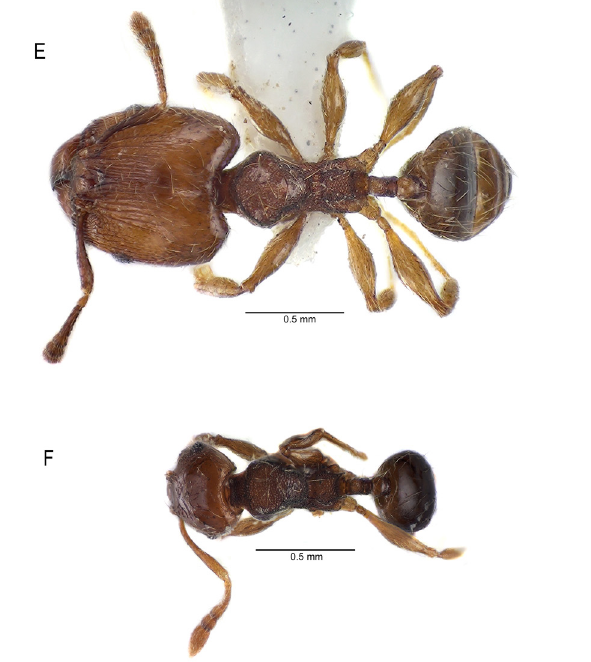
Fig 2. Pheidole protaxi sp. nov., habitus: left lateral view. C: holotype major worker, [LBSA_SA_14013667]. D: paratype minor worker,